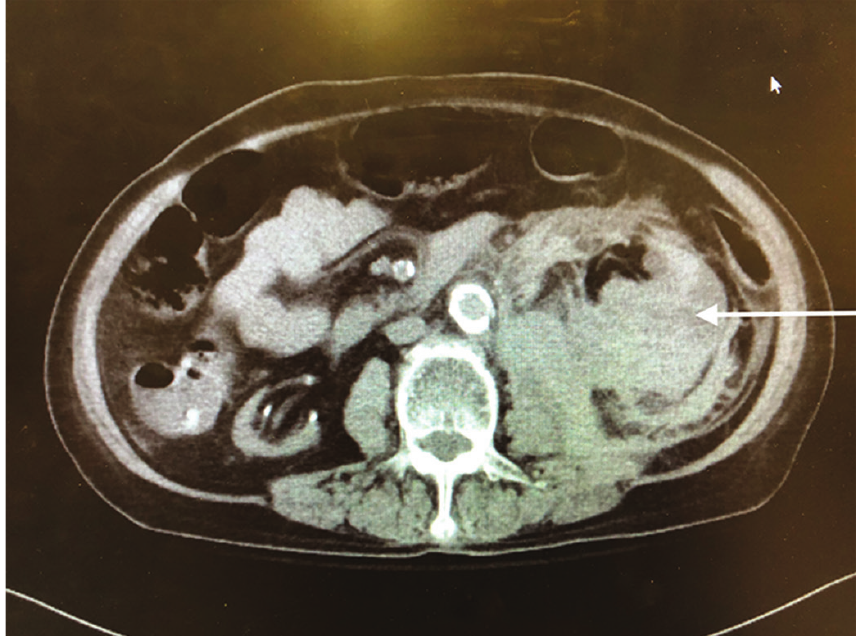
Figure 1: Axial CT image of left retroperitoneal hemorrhage.The arrow refers to the large retroperitoneal